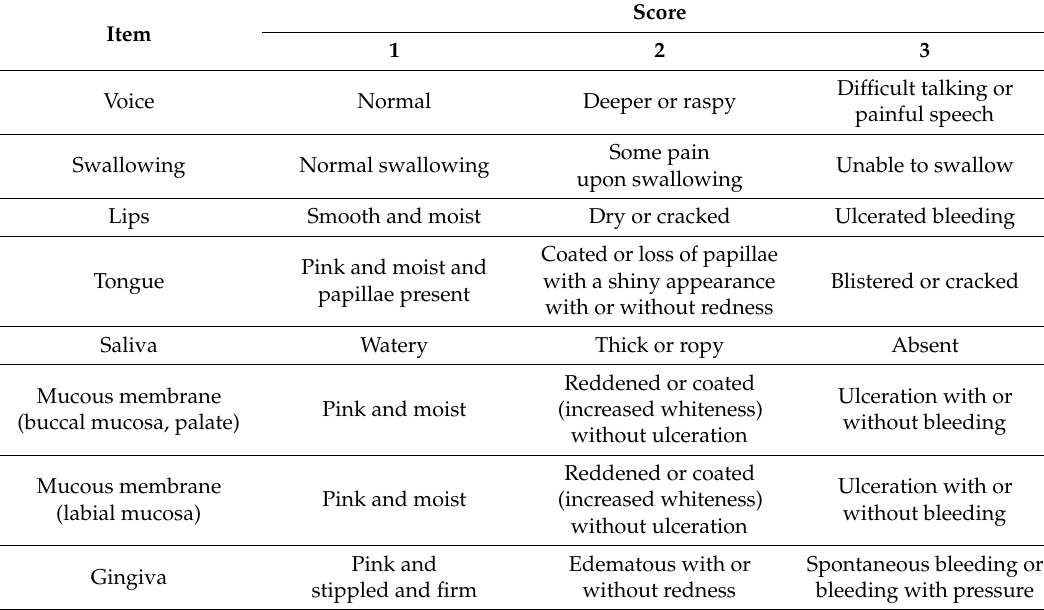
Table 2. Oral Assessment Guide (OAG) modified for monitoring the oral health of patients undergoing chemotherapy.